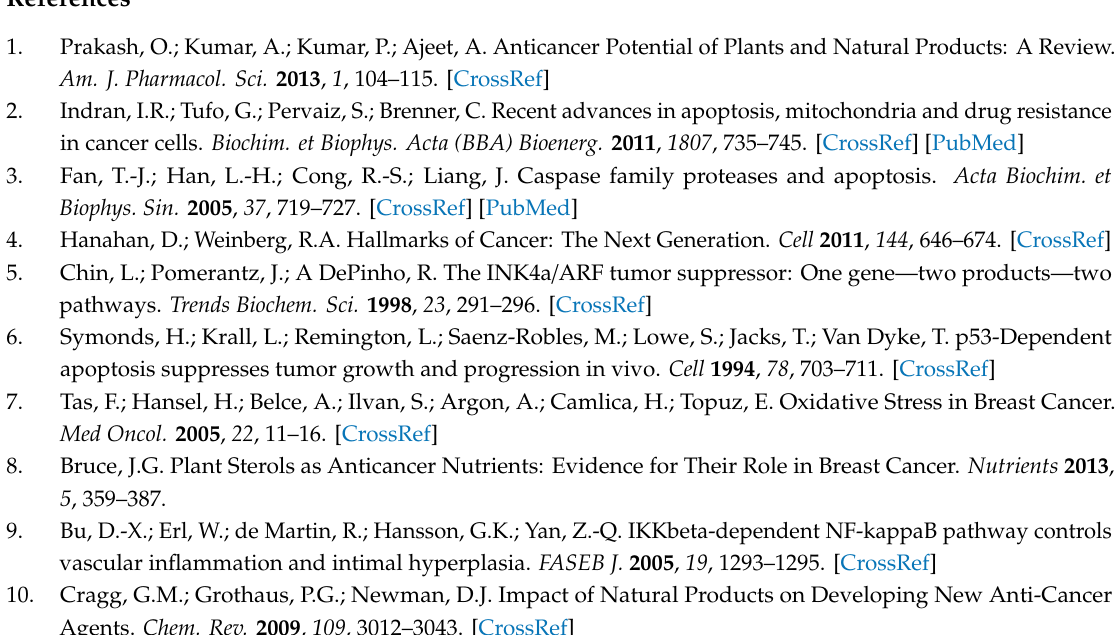
Figure S1: FT-IR spectrum of single compound, Figure S2: MS spectrum of single compound, Figure S3: Structure of isolated compound 26,27-dinorcholest-5-en-3- β -ol (It was named as